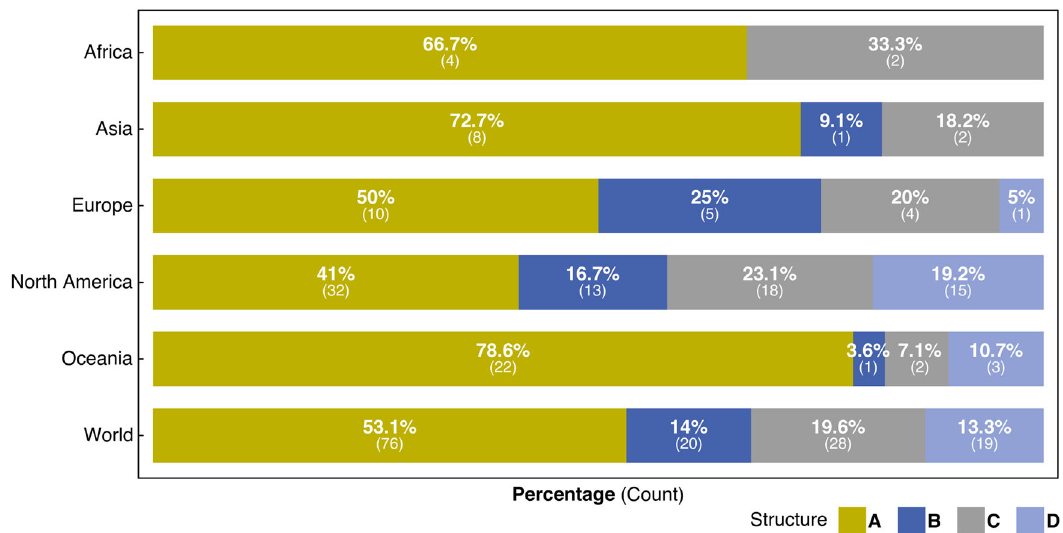
Fig. 2 Structures of sea-level rise projections used globally. Respondents formally structure the use of sea-level rise projections for planning purposes in four ways: A is a singular estimate, B is a low and a high estimate, C is a low, intermediate, and high estimate, and D is a low, intermediate, high, and high- end estimate. Shown are aggregated responses for fi ve distinct geographical regions and the